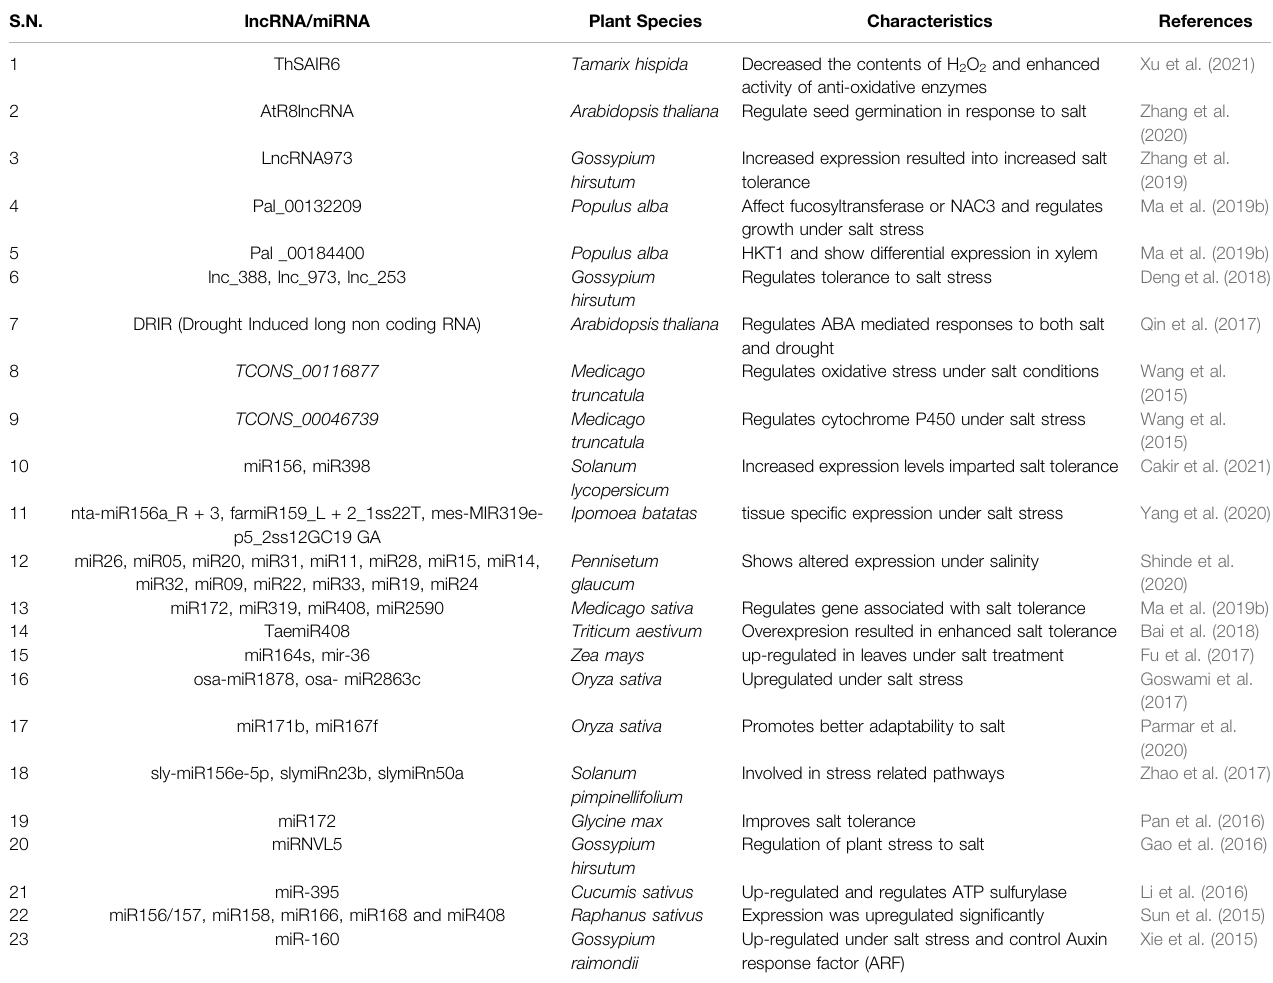
TABLE 1 | Long non coding RNAs/miRNAs involved in imparting salt tolerance.